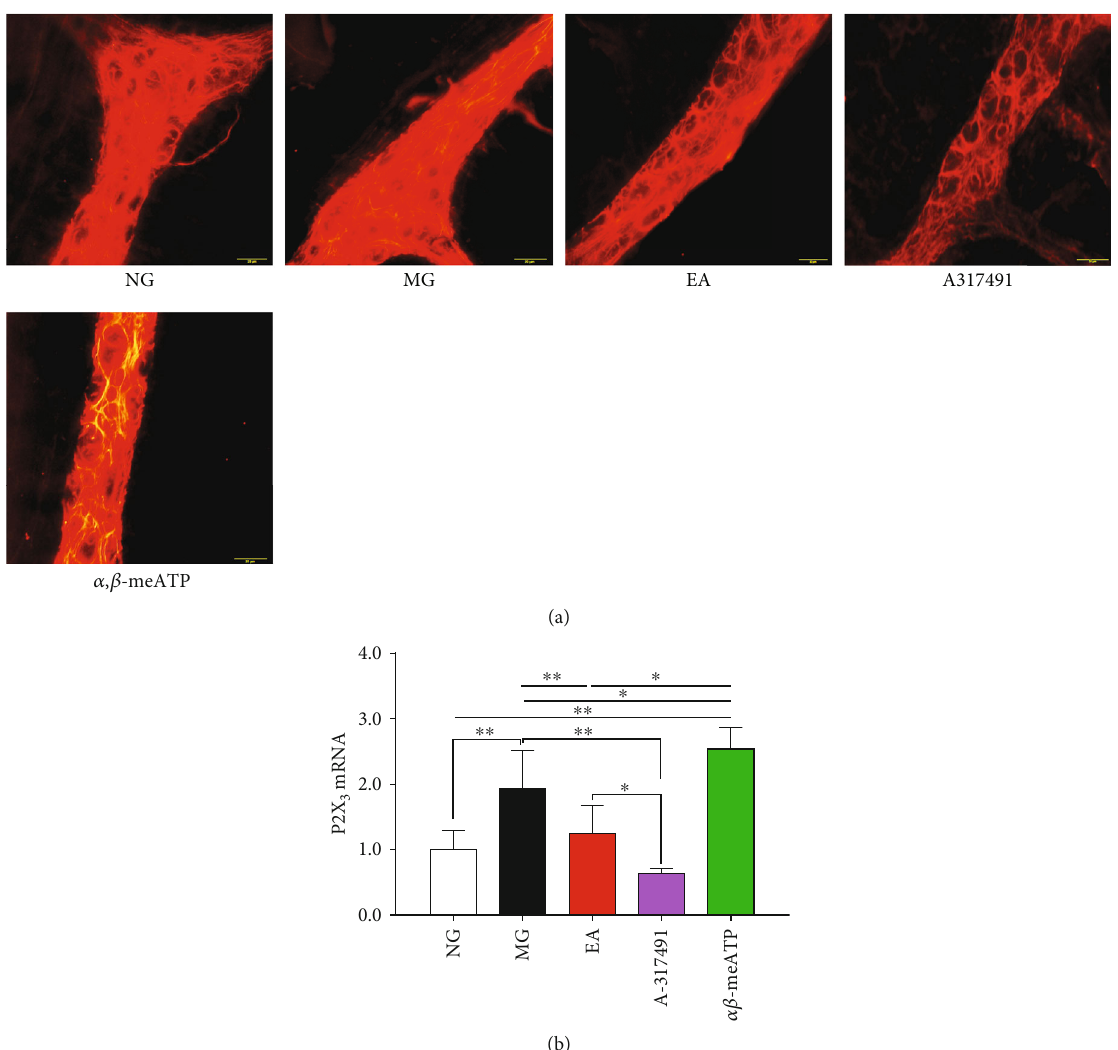
Figure 2: P2X protein and mRNA expression in the colonic myenteric plexus. ( a) Distribution of the P2X 3 plexus (scale bar =20 μ m). (b) P2X mRNA expression in colon. ∗ P < 0 : 05 , ∗∗ P < 0 : 01 3